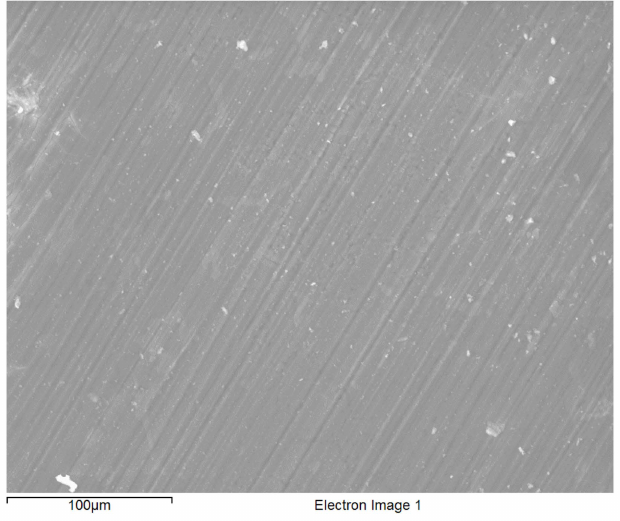
Figure 1. Typical BTSE coated AZ91D alloy